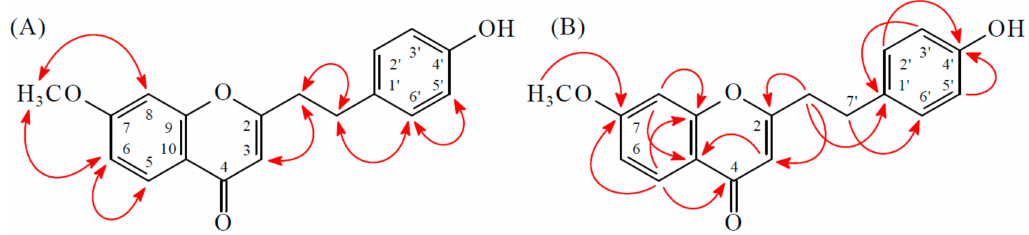
Figure 2. Key NOESY ( A ) and HMBC ( B ) correlations of 1